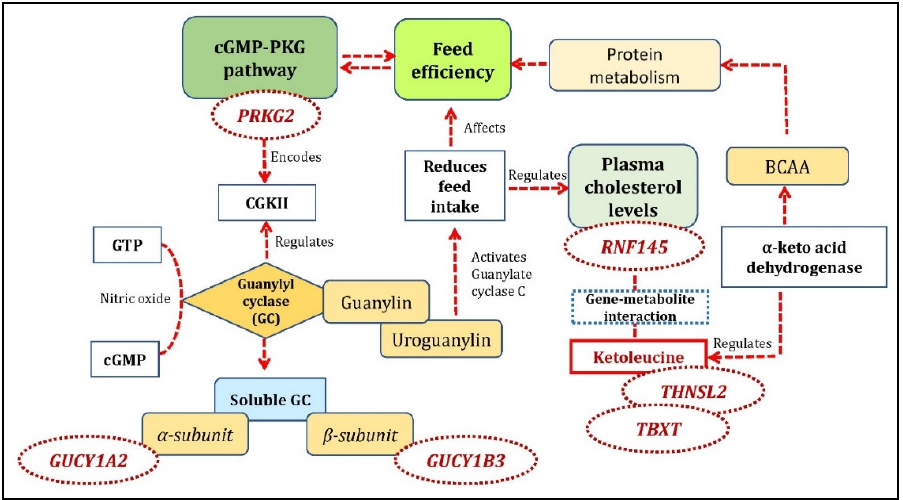
Figure 6. An overview of gene-metabolite pairs affecting the cGMP-PKG pathway involved with feed efficiency.